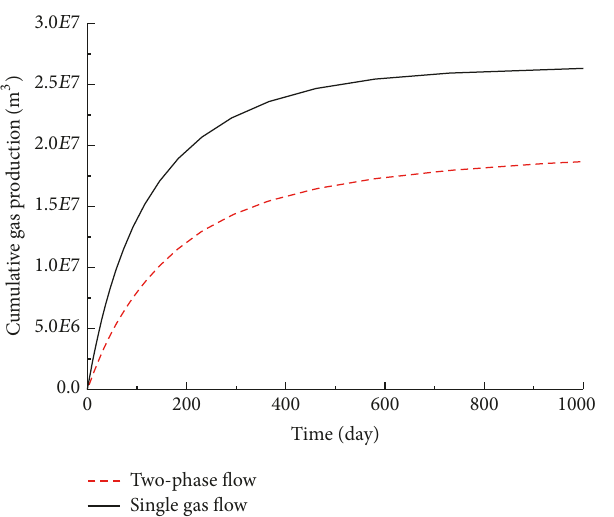
25mFracture spacing of 36.2 Fracture spacing of Figure 7: Effect of fracture density on gas production rate.